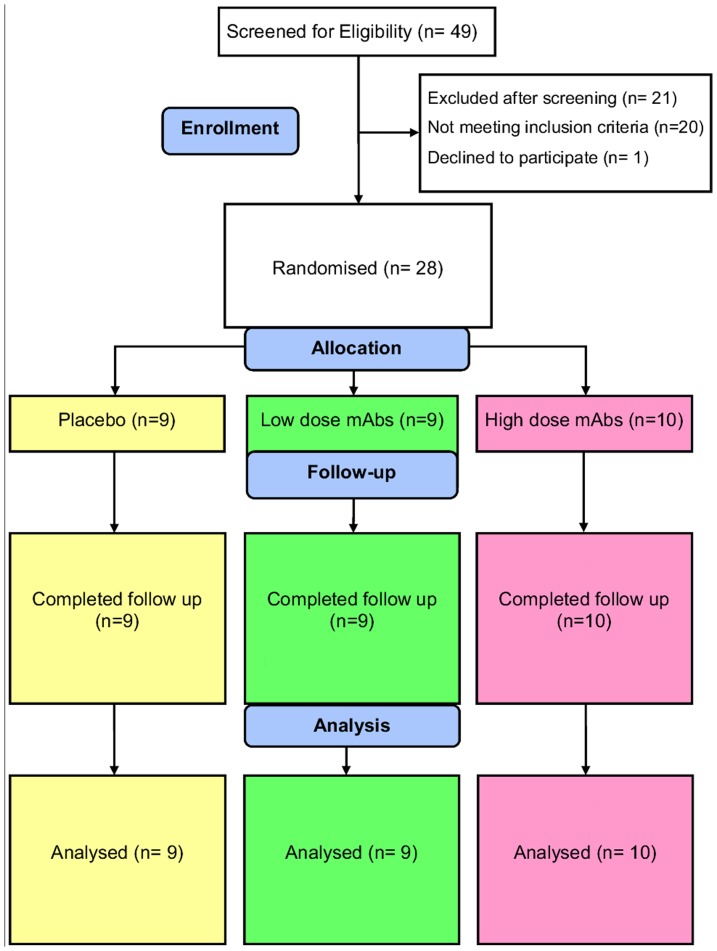
CONSORT diagram of the MABGEL 1 clinical trial.